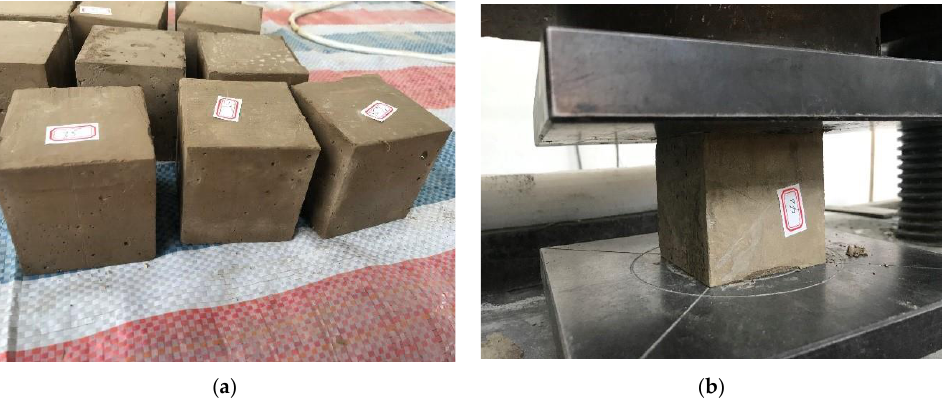
Figure 3. Strength characteristic test of the cement soil : ( a ) Preparation of the standard cubes. And ( b ) Unconfined compression test.